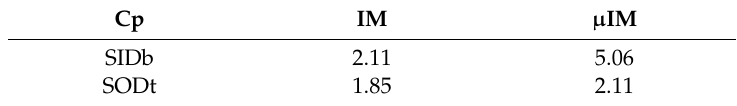
Figure 17. Distribution of SODt values for IM (red) and µ IM (green). Table 10. Axiomatic matrix for the µ IM machine. Control functions are indicated in